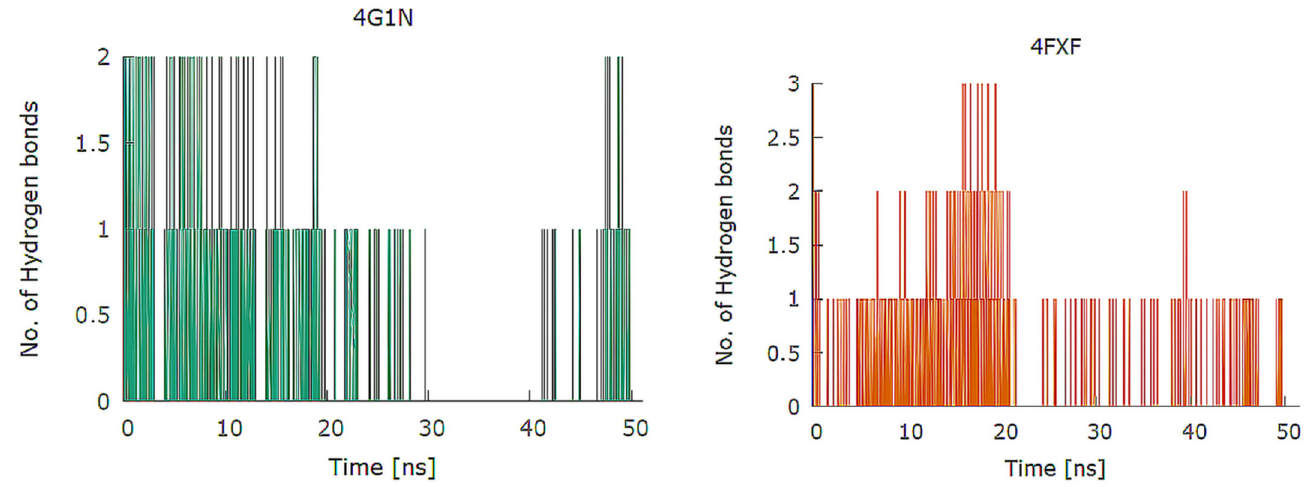
Figure 7. Number of H-bonds formed between protein–ligand complexes with respect to the pro- duction period . tion